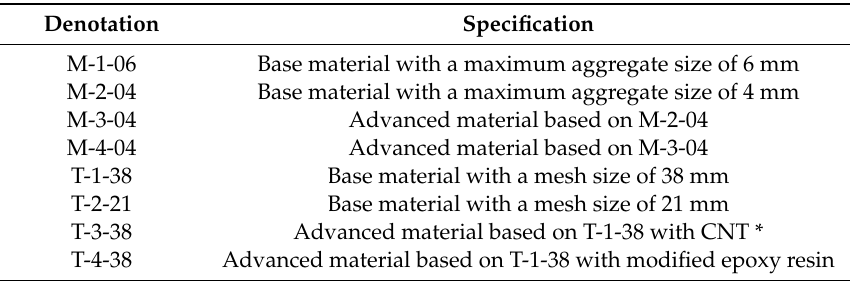
Table 1. Details of mortars and